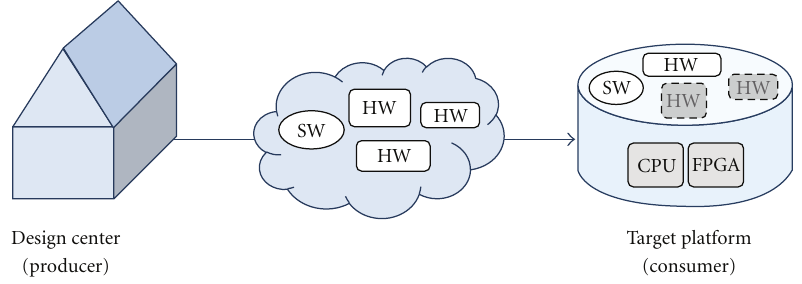
Figure 1: Proof carrying hardware scenario.